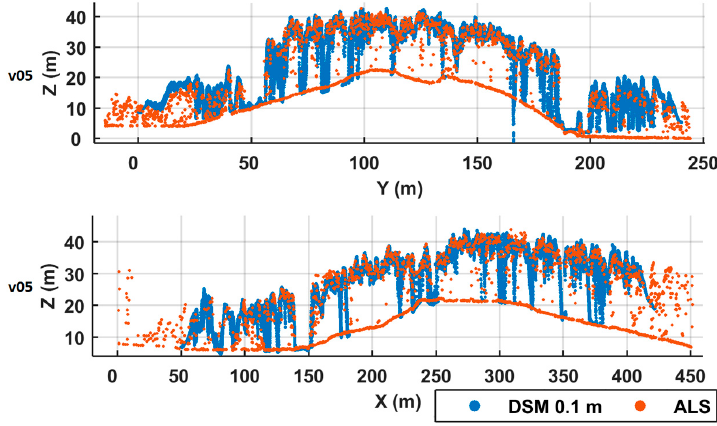
Figure 5. Comparison of photogrammetric and airborne laser scanning (ALS) point cloud profiles in test sites v01 and v05.